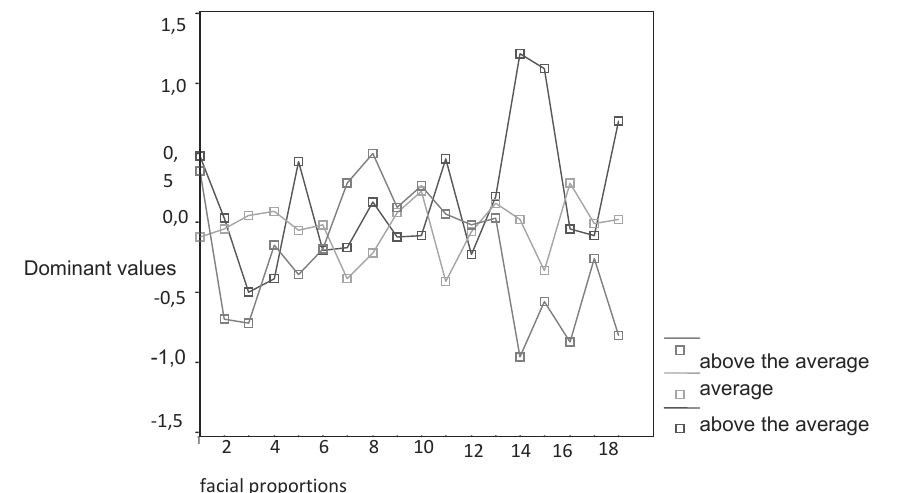
Fig. 1. Relation between facial metric parameters and desirable to be friend – not desirable to be friend.